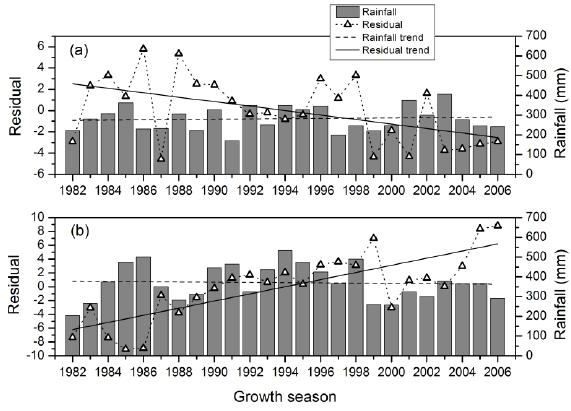
Figure 8. Trend of residuals plotted against rainfall per growth seasons for the typical samples: ( a ) The location of significant decrease for residuals; ( b ) The location of significant increase for residuals.